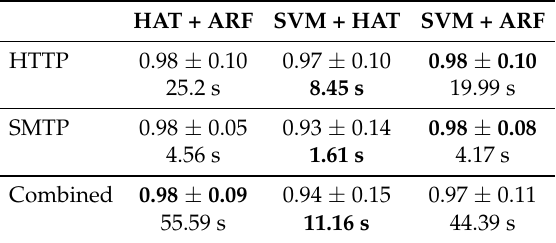
Table 3. Heterogeneous